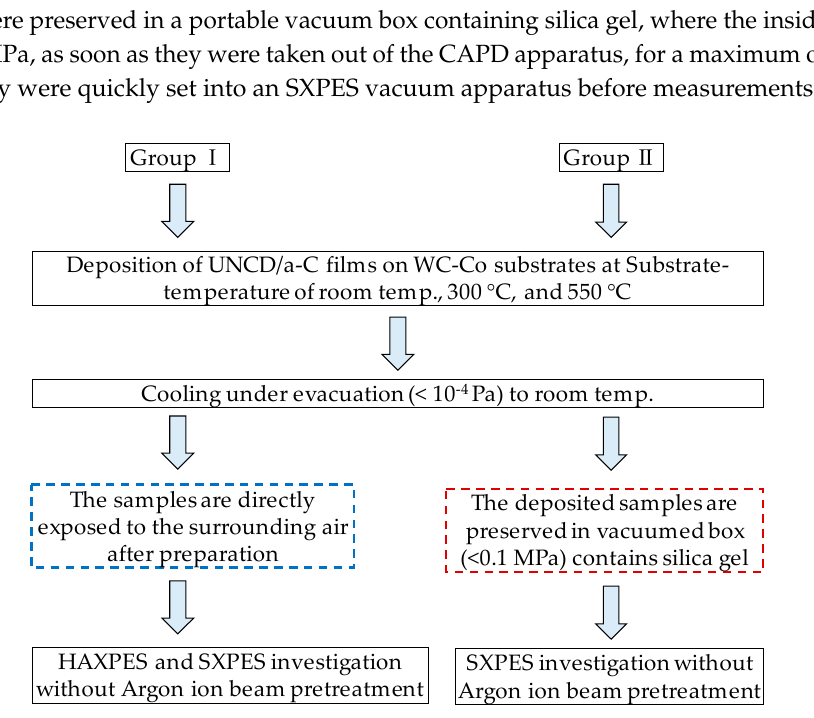
Figure 1. Schematic diagram of the experimental procedures.